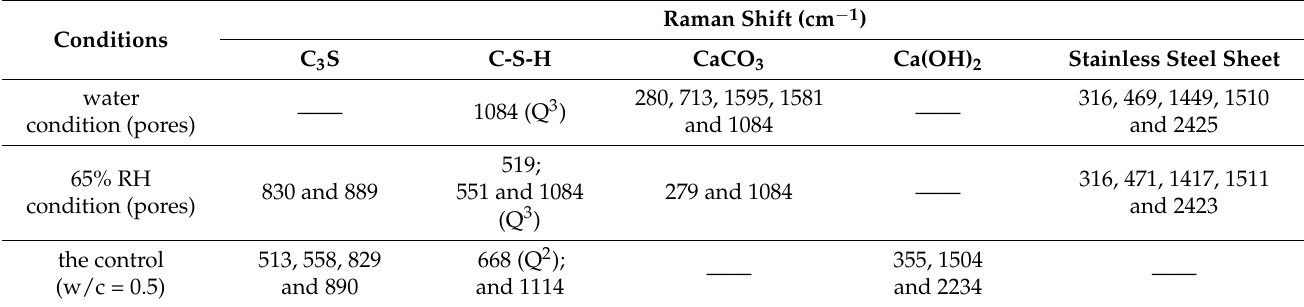
Table 2. Raman shifts and distribution of hydration products.